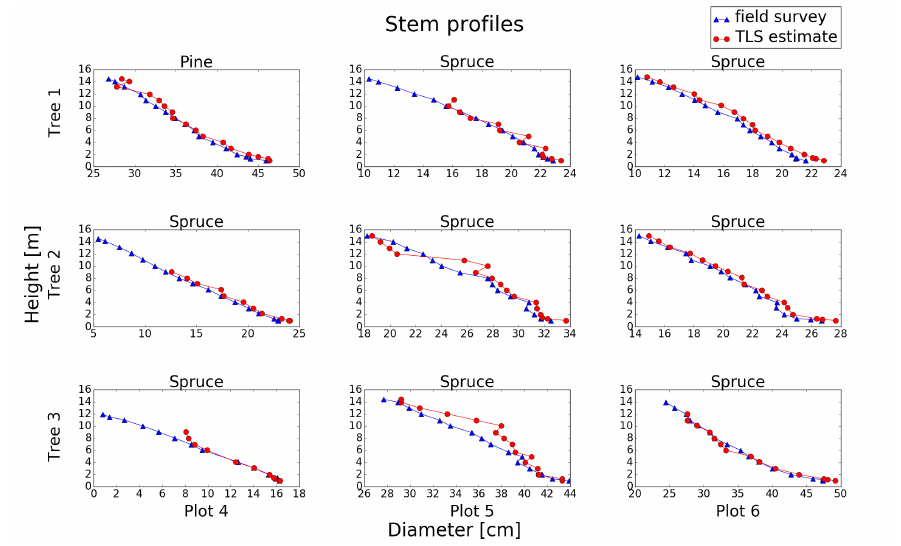
Figure 15. Stem profiles of the trees in Plots 4–6. The parameter settings used in the stem profile detection method were: voxel size of 3 cm, curvature weight of 0.75 and of cluster weight 15.